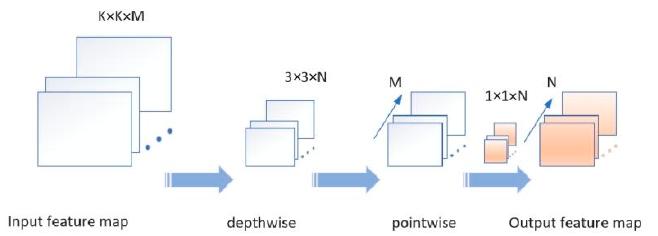
Figure 6. Structure of the block of depth-wise separable convolution.